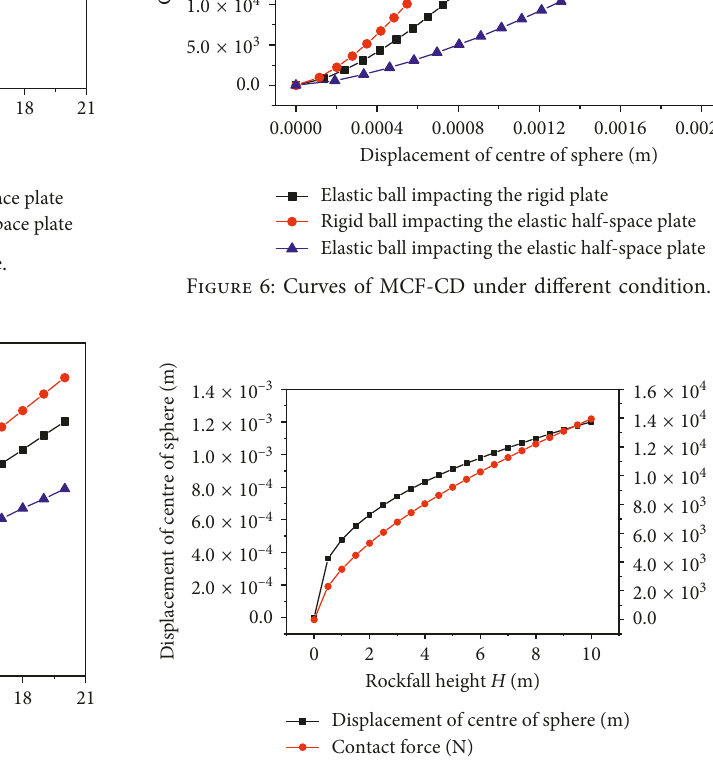
Figure 7: Curves of MCF-RH and